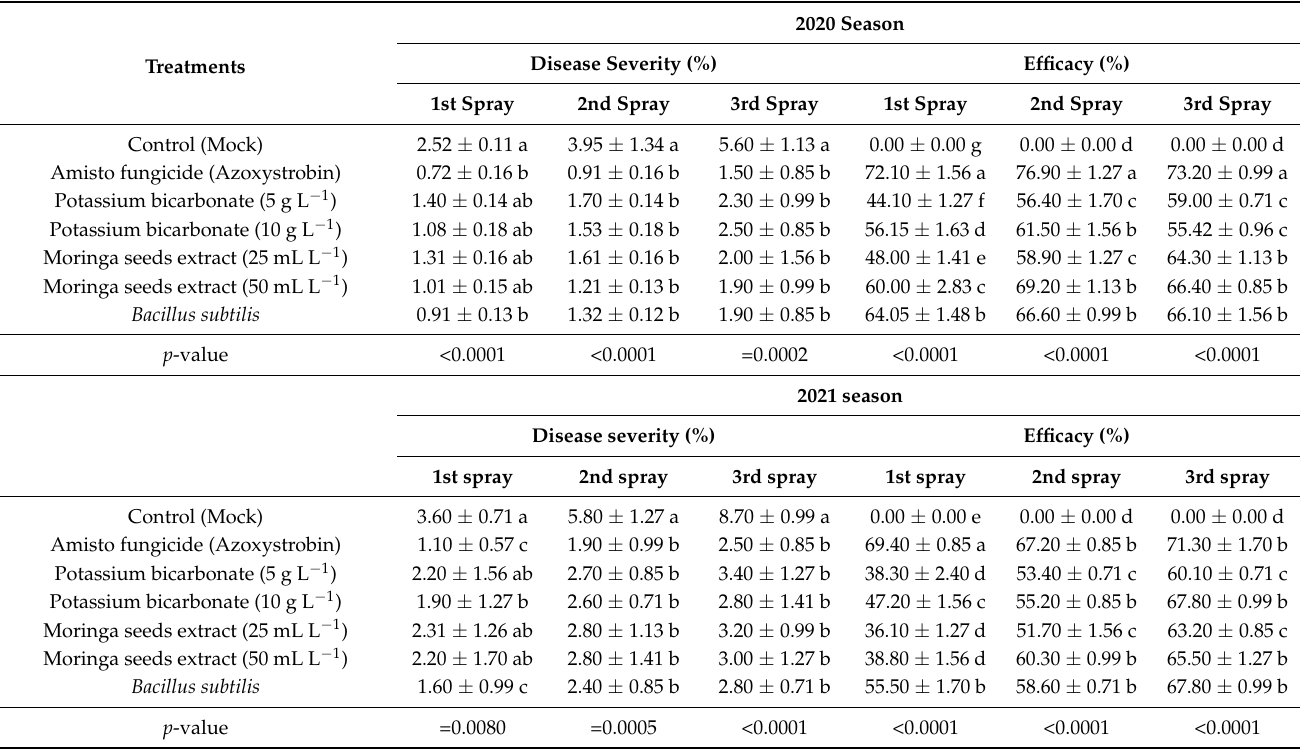
Table 1. Efficacy of different treatments against powdery mildew disease caused by Erysiphe betae under field conditions during the 2020 and 2021 seasons a